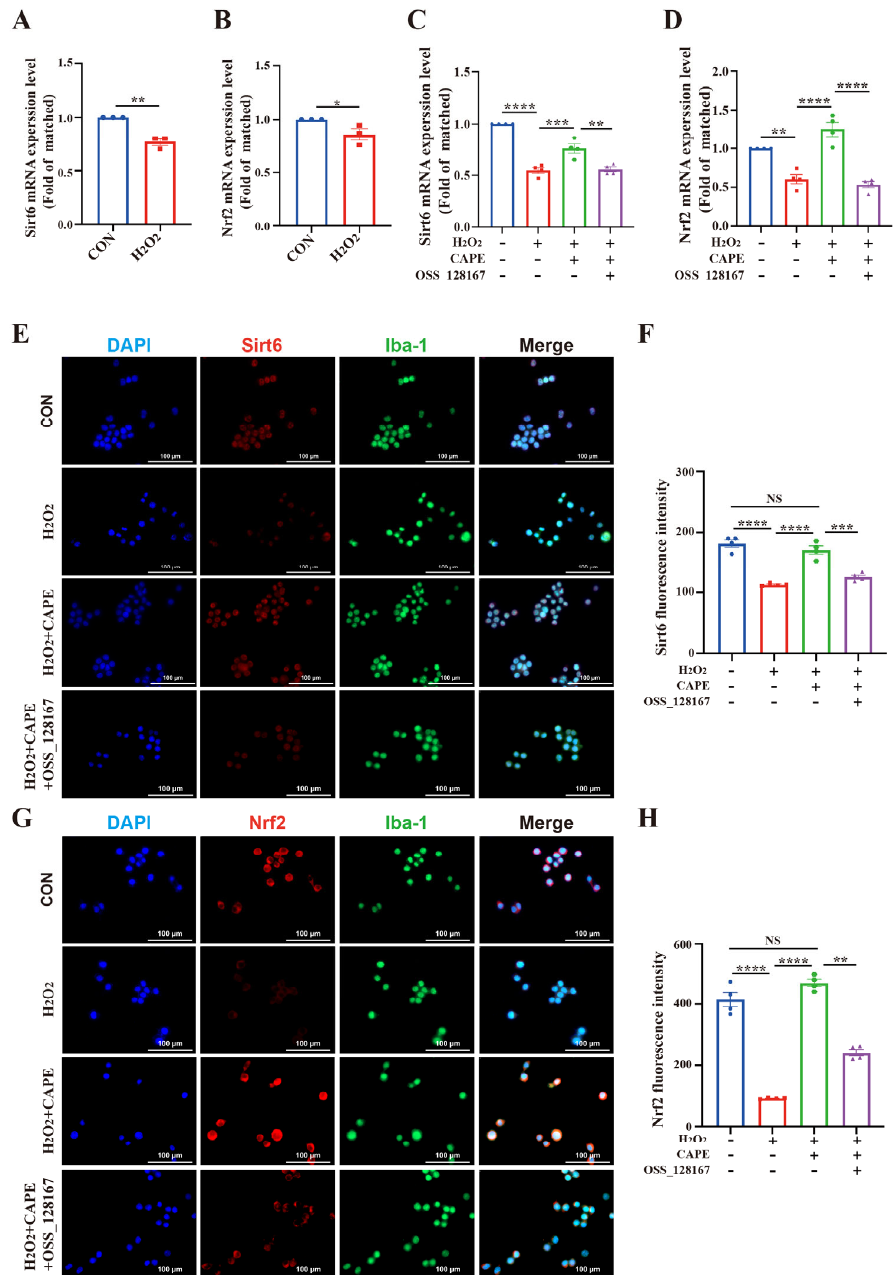
Figure 7. CAPE pretreatment increases Sirt6/Nrf2 expression levels in H 2 O 2 -induced BV2 cells. ( A ) RT-qPCR analysis of Sirt6 expression between the CON group and H 2 O 2 group ( t -test, p value = 0.021; n = 3 per group). ( B ) RT-qPCR analysis of Nrf2 expression between CON group and H 2 O 2 group ( t -test, p value = 0.0113; n = 3 per group). ( C ) RT-qPCR analysis of Sirt6 expression among four groups (one-way ANOVA, p value < 0.0001; n = 4 per group). ( D ) RT-qPCR analysis of Nrf2 expression among four groups (one-way ANOVA, p value < 0.0001; n = 4 per group). ( E ) Immuno fl uorescence staining of Sirt6 in BV2 cells after treatment with the four conditions. ( F ) Quanti fi cation of Sirt6 fl uorescence intensity mean value in the four conditions (one-way ANOVA, p value < 0.0001; n = 4 per group). ( G ) Immuno fl uorescence staining of Nrf2 in BV2 cells after treatment with the four conditions. ( H ) Quanti fi cation of Nrf2 fl uorescence intensity mean value in the four conditions (one-way ANOVA, p value < 0.0001; n = 4 per group). Three or four independent experiments were done and for each, three replicates were plated. (* p < 0.05; ** p < 0.01; *** p < 0.001; **** p < 0.0001; NS regarded as not signi fi cant).